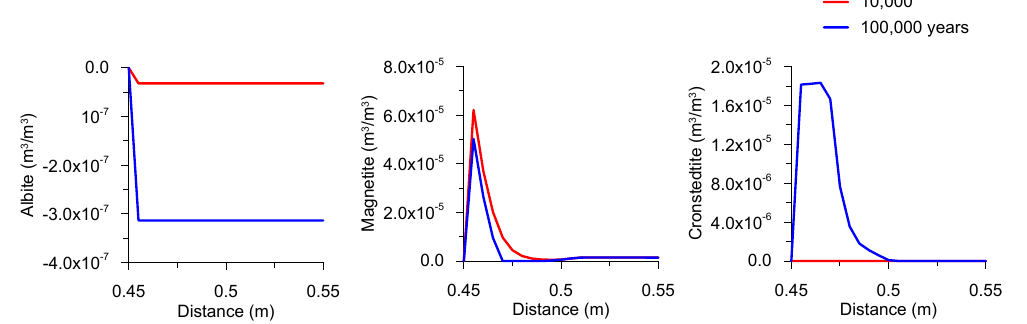
Figure 10. Volumetric fraction of minerals of the model with 100,000 years interaction (r c = 2 µ m y − 1 ). For albite the variation of the volumetric fraction is plotted. Positive values mean precipitation and negative values mean dissolution. The interface between steel and bentonite is at 0.45 m. Results at 10,000 and 100,000 years of interaction are compared.